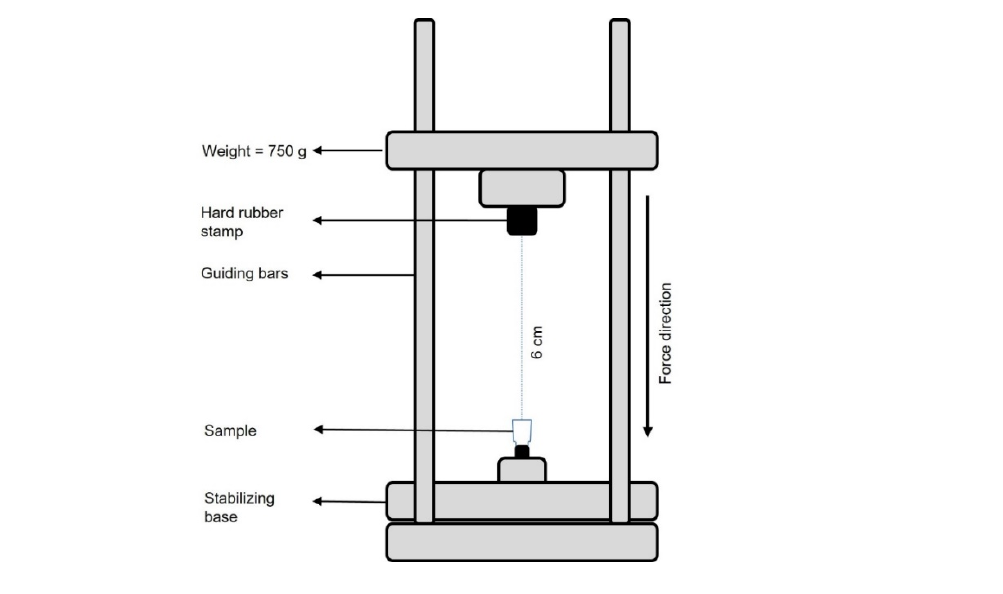
Figure 5. Schematic diagram of the tapping device.